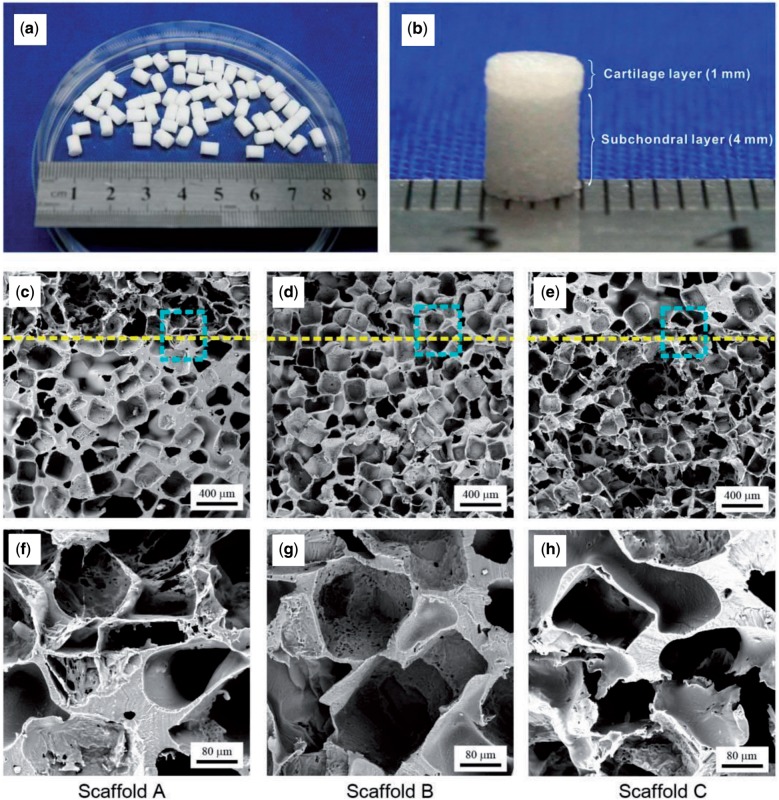
Images of prepared bilayered PLGA scaffolds. (a, b) Gross view of scaffold A. (c–h) SEM micrographs of three groups of bilayered scaffolds. The dashed lines indicate the border of the two layers. The lower row displays the corresponding magnified images of the squared regions in the middle row.